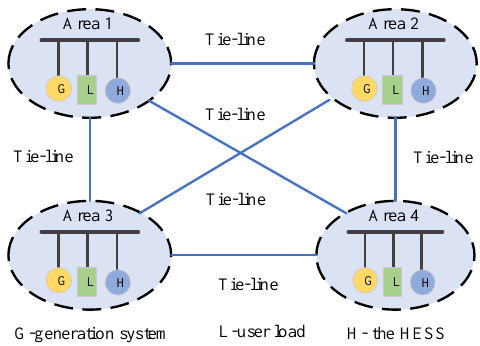
Figure 1. Topological structure diagram of four ‐ area interconnected power system.